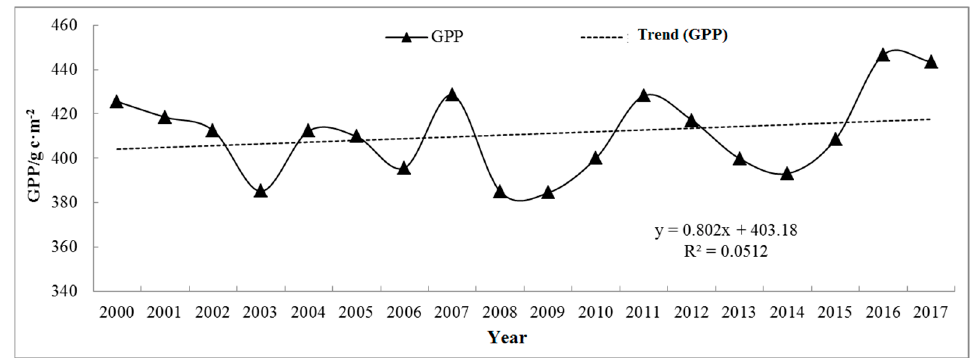
Figure 4. Annual variation of GPP in the Altay Mountains (2000–2017).